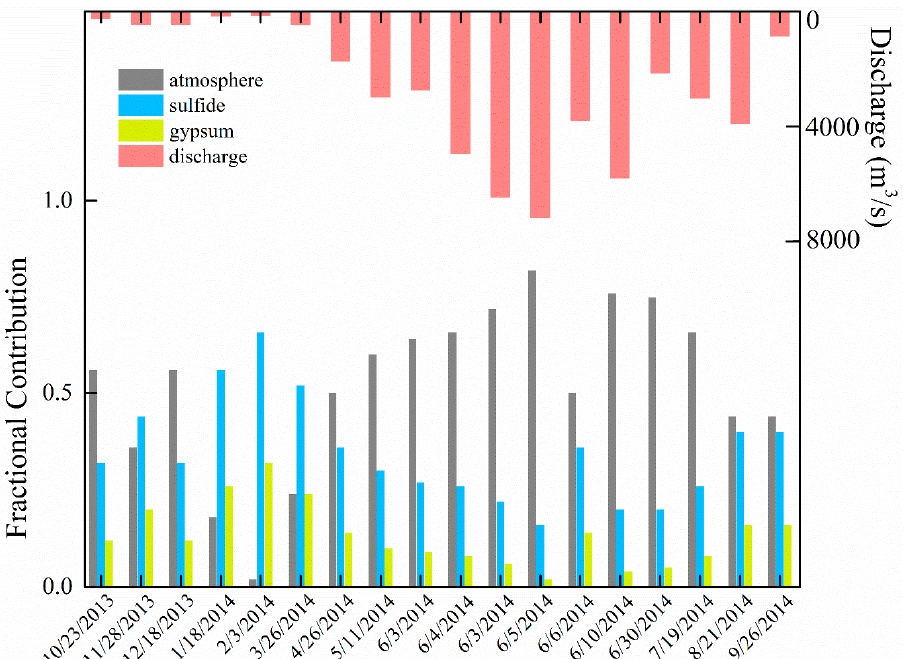
Figure 5. The fractions of riverine sulfate contributed by different three end-members ( F at , F sul , and F gyp ) to the Liujiang River.